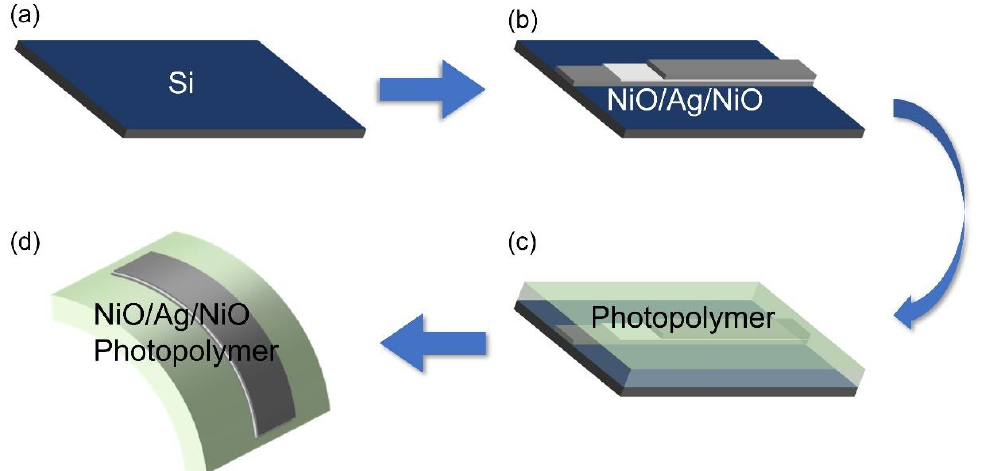
Figure 2. Steps of fabricating ultra-smooth NAN film by template stripping. ( a ) Si substrate was cleaned as the template. ( b ) NAN film was deposited onto the Si template by electron beam evaporation. ( c ) Photopolymer (NOA63) was spin-coated as the backing film. ( d ) The NAN film adhered to the cured photopolymer film was stripped.